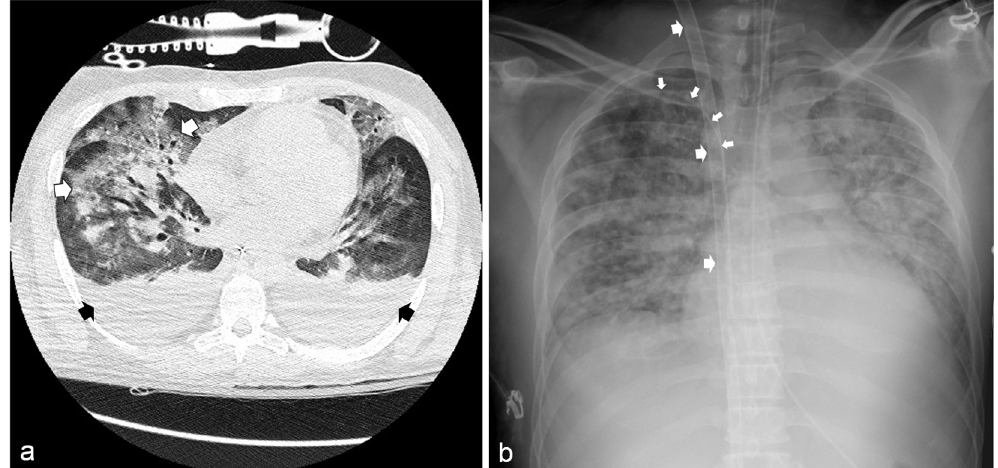
Figure 2. ( a ) Chest computed tomography showing bilateral pleural effusion (black arrows) and diffuse ground-glass infiltrates (white arrows). ( b ) Chest radiography showing the bi-caval dual-lumen catheter placed in the right jugular vein (large arrows) and the central venous catheter in the right subclavian vein (small arrows).